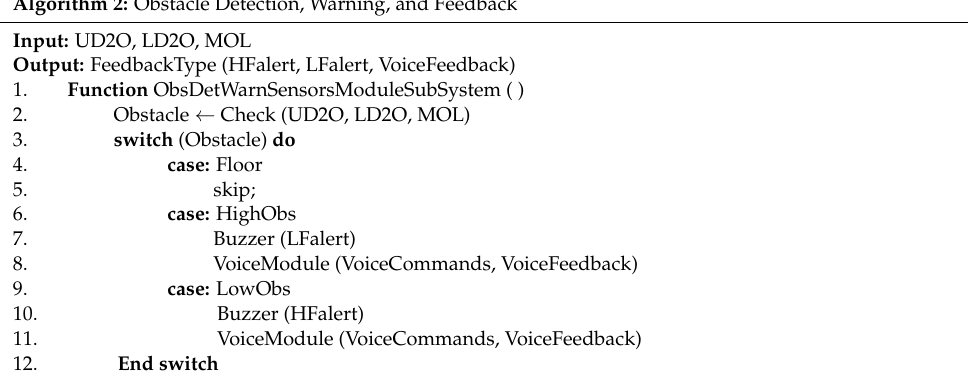
Algorithm 2: Obstacle Detection, Warning, and